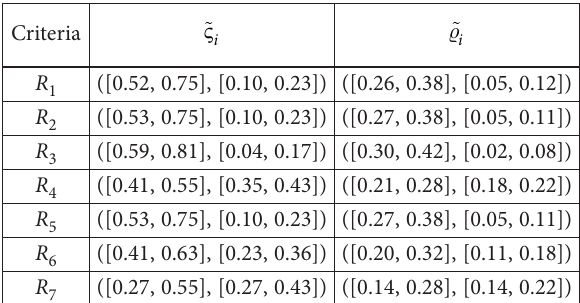
Table 7. Criteria